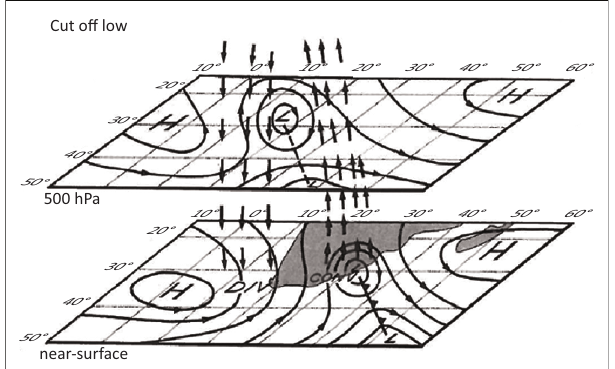
FIGURE 2: Cut-off low circulation patterns at near surface at 500 hPa